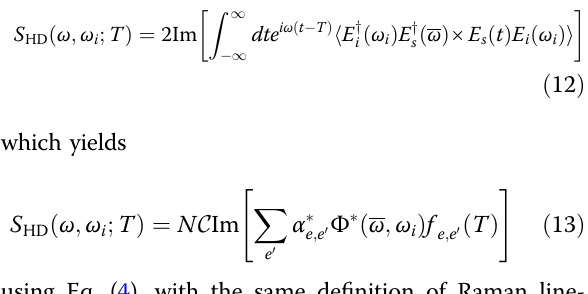
ð 13 Þ using Eq. (4), with the same de fi nition of Raman line- shape function and electronic polarizability as in Eq. (8) j 2 = π . For the molecules in and (9). C ¼ jE s ; ω j 2 jE i ; ω i